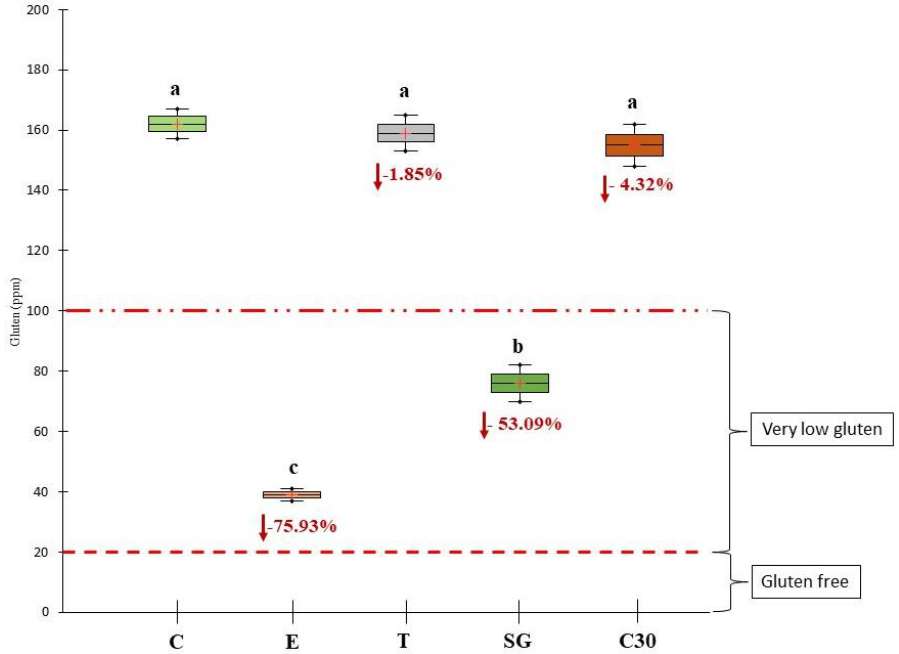
Figure 2. Percentage reduction and gluten content of the experimental beer samples. Different letters indicate statistically significant differences ( p < 0.05), following pairwise comparison with Tukey’s HSD test. C = untreated sample; E = enzymatic-treated sample; T = tannins-treated sample; SG = silica gel-treated sample; C30 = long cold maturation.